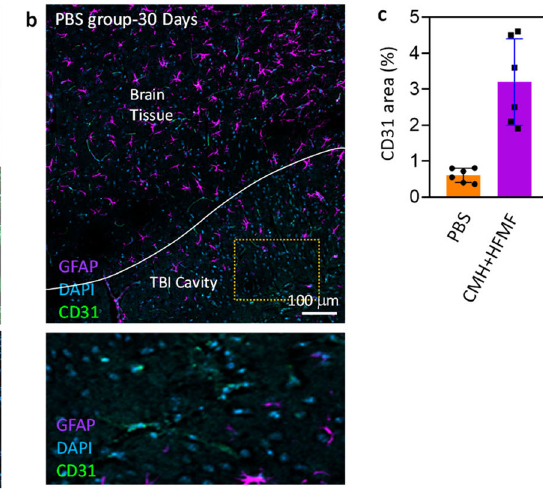
after treated by cys-GMH+HFMF group (I and II: a cross-section view of EC-lined channel). Scale bar=150 µ m. b The fl uorescence images of control group. c Quanti fi cation of CD31 area of images at TBI cavity Error bars represent mean ± s.d., n =